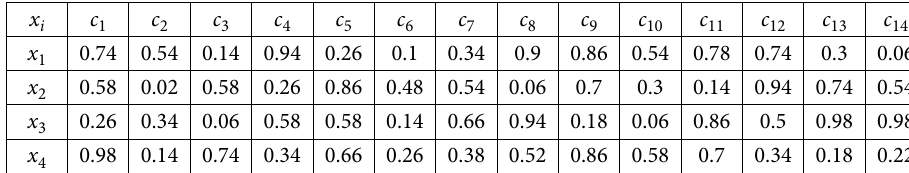
Table 3. The risk evaluation matrix